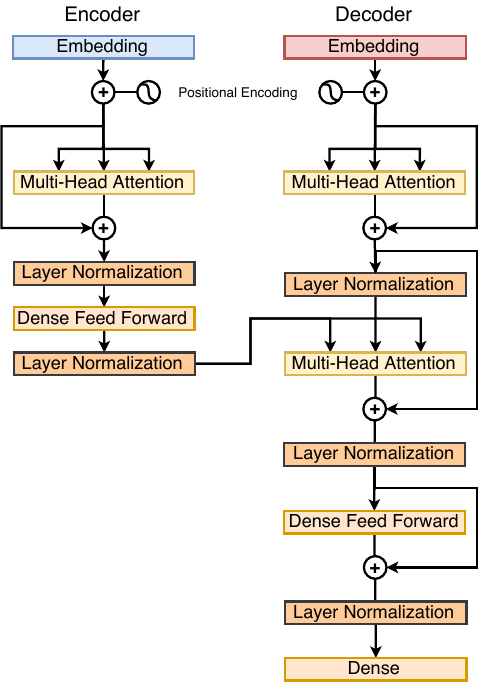
Figure 8. Transformer architecture